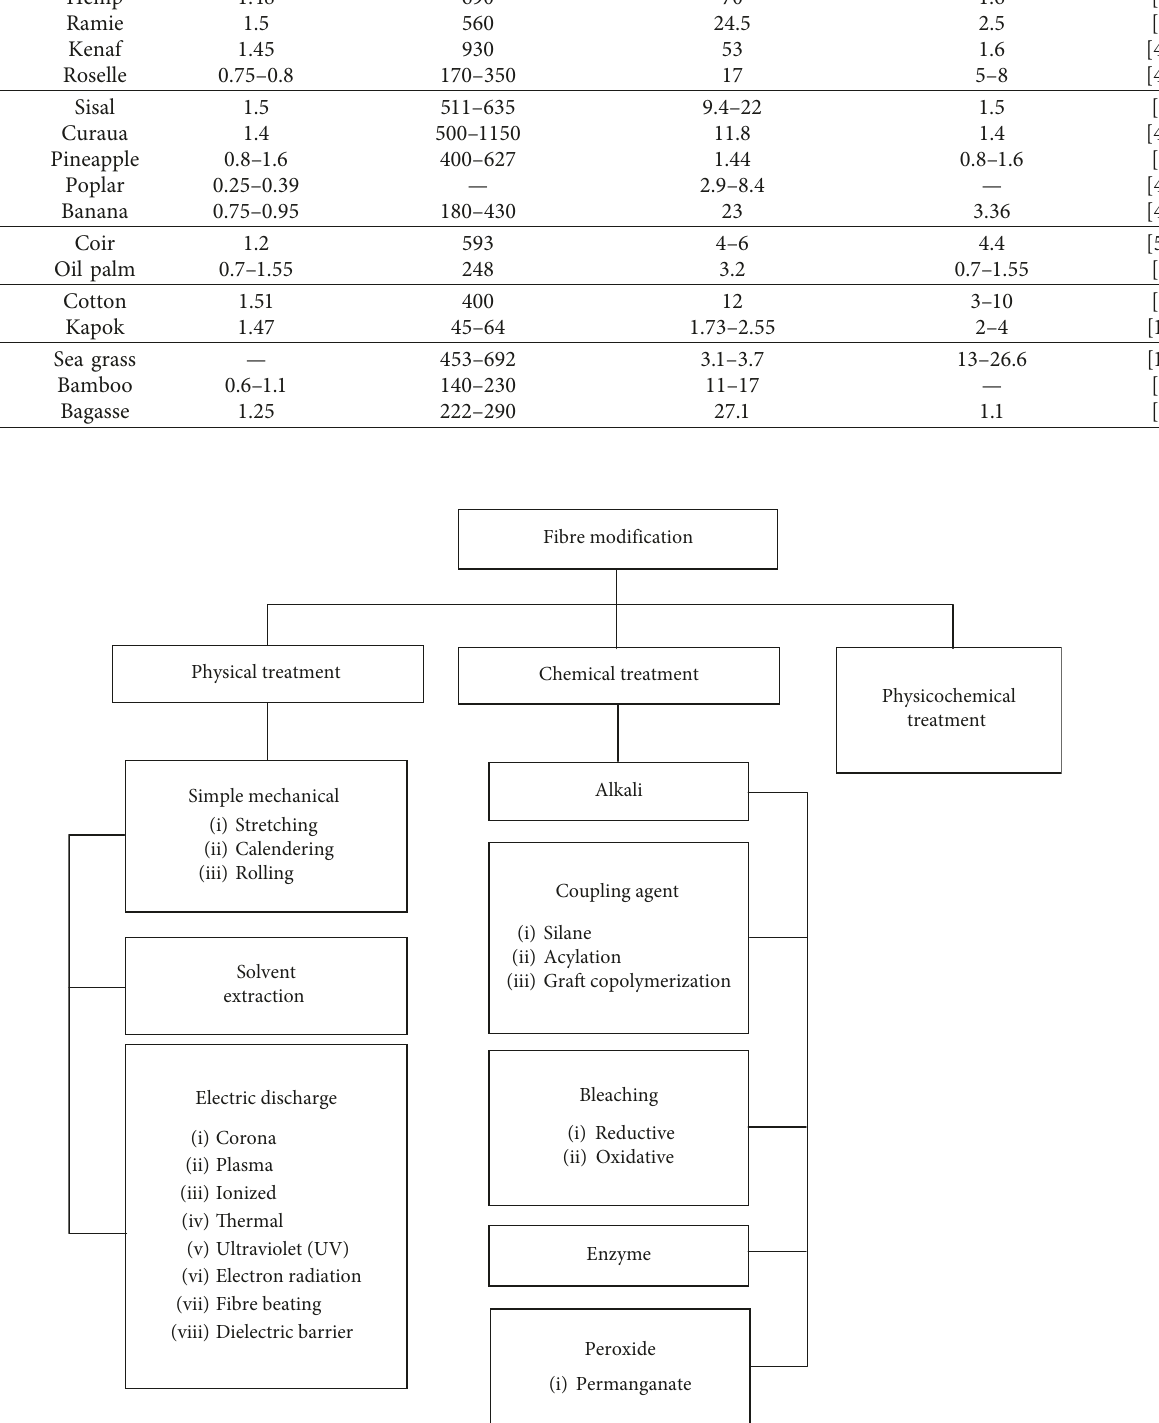
Figure 4: Fibre modification